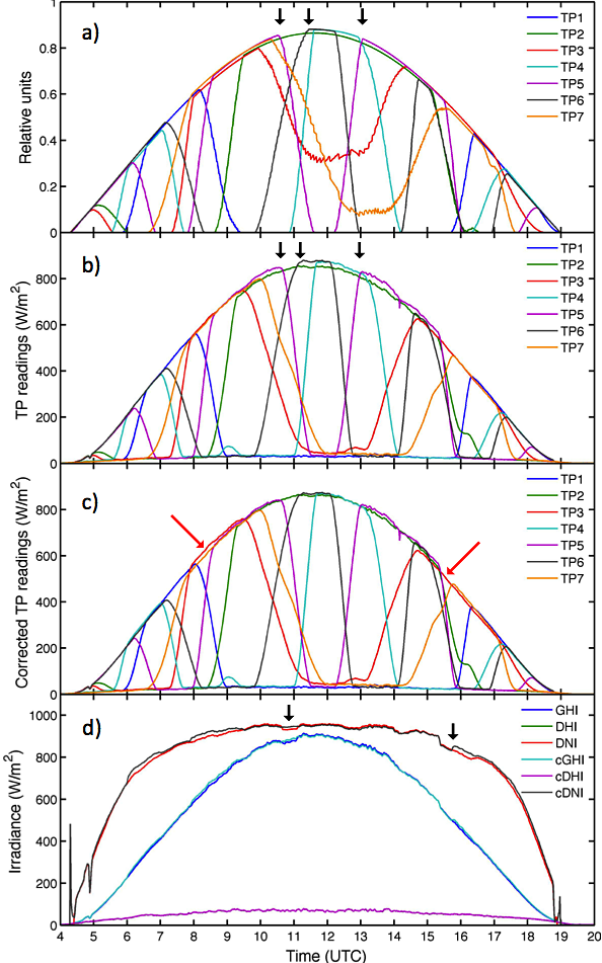
Figure 5. (a) Theoretical model of reading outputs from each of the SPN1 7 individual thermopiles (TPs), including dome lensing, for 1 August 2013 at Payerne. (b) Actual SPN1 TP readings for this same day and place on a clear-sky day. (c) TP readings after correction for dome lensing. (d) Measured and corrected GHI, DHI and DNI measurements for this clear-sky